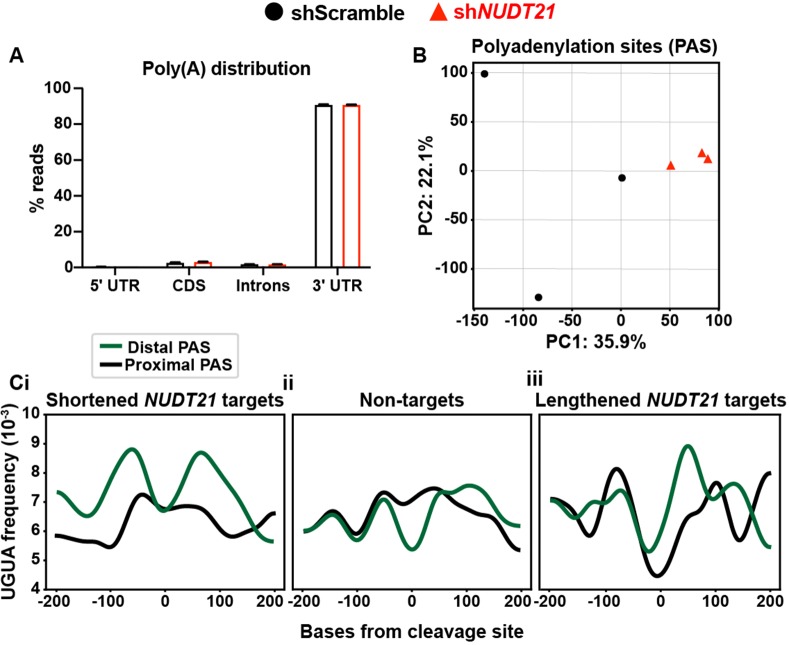
Accessory analyses support PAC-seq validity.(A) >90% of filtered reads map to the 3′ UTR. (B) Control and shNUDT21-infected human neurons segregate by principle component analysis (PCA) of alternative polyadenylation. (Ci) The CFIm25 binding motif, UGUA, is enriched upstream of the distal cleavage and polyadenylation site (PAS) of NUDT21-regulated mRNAs that shorten after NUDT21 knockdown. (ii) There is almost no upstream UGUA frequency difference between proximal and distal cleavage sites in mRNAs not affected by NUDT21 loss. (iii) There is a slight UGUA enrichment upstream of the proximal cleavage site in NUDT21-regulated mRNAs that lengthen after NUDT21 loss.